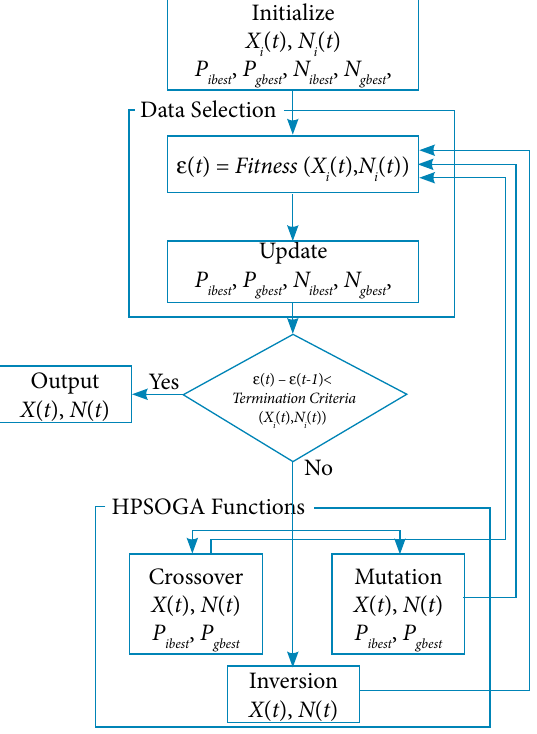
Figure 3. Proposed HPSOGA